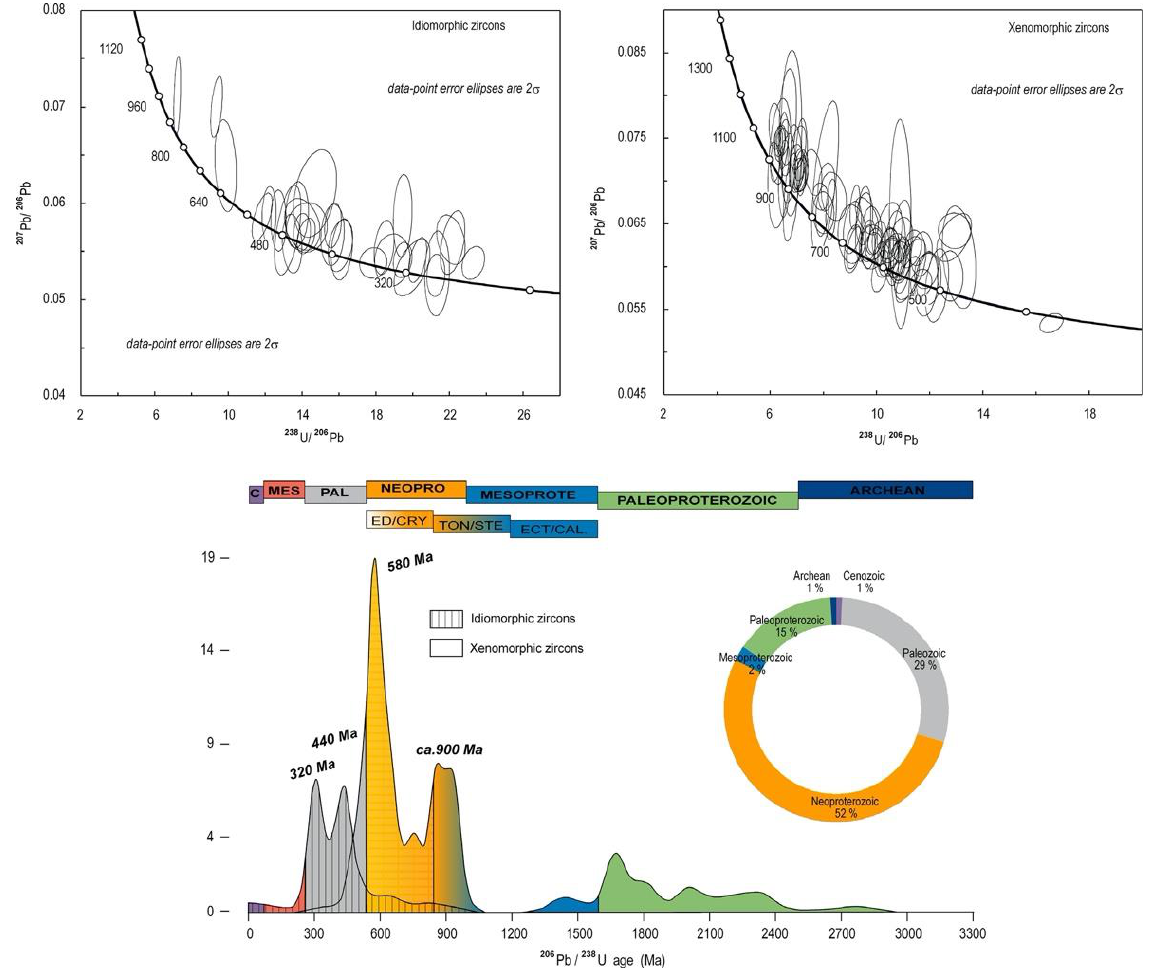
Figure 11. Tera-Wasserburg and KDE age distributions of tb-18-06 sample. Zircon age distribution has been separated according to idiomorphic and xenomorphic zircon morphology.